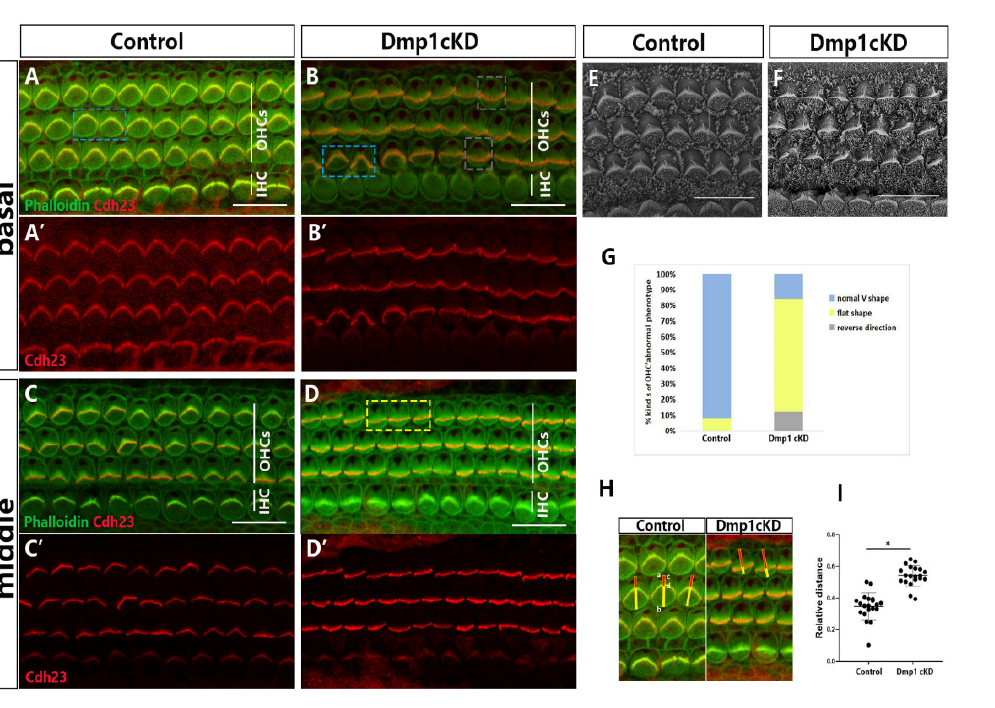
Figure 2. Stereocilia hair bundles defected in Dmp1 cKD mice. ( A – D ): Whole-mount images of middle and basal turns of cochlea from control and Dmp1 cKD mice, Cdh23 staining of stereocilia junction protein was singly showed in ( A’ – D’ ). In the control cochlea ( A , C ), the stereocilia bundles were “V”-shaped and essentially symmetrical (blue bracket), while many hair cells’ stereocilia bundles had a defective shape such as a flat shape (yellow bracket) and reverse direction (grey bracket) in Dmp1 cKD cochlea ( B , D ). ( E , F ): SEM of hair cells from basal cochlear turns of Dmp1 cKD and control mice at P1. ( G ): Stacked bar chart of ratio of kinds of OHC hair bundles phenotype in knockdown and control mice (3 mice per group). ( H , I ): The amesiality of hair bundles in Dmp1 cKD mice. As shown in Figure ( H ), the stereocilia bundles were globally moved toward one side (inner hair cells side) in single cells of Dmp1 cKD mice. It can be quantified by the ratio of cd/ab. ab (yellow line): the distance from the center of the blank area of the cuticular plate to the other side of the hair cell (close to the inner hair cell side). cd (red line): the center of the blank area to the V-shape vertex of hair bundles. Moreover, the result was shown as the cluster diagram in ( I ). Statistical significance was calculated using a t -test. * p < 0.05. Scale bars: 10 µ m ( A – D ) and 5 µ m ( E , F